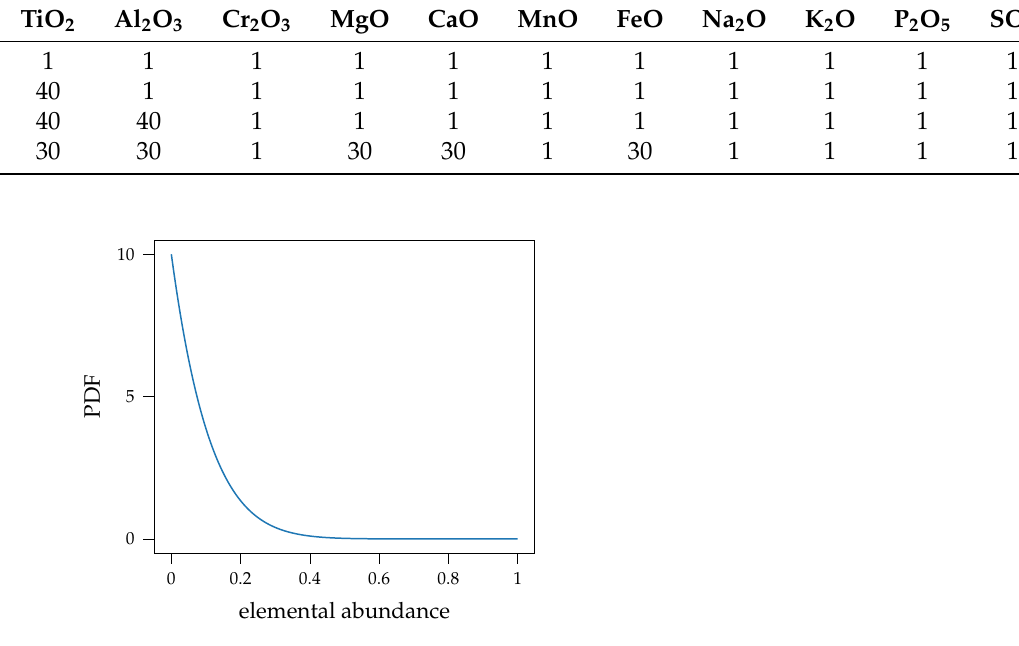
Figure 6. The probability distribution function of the prior on the elemental abundances for a theoretical abundance below